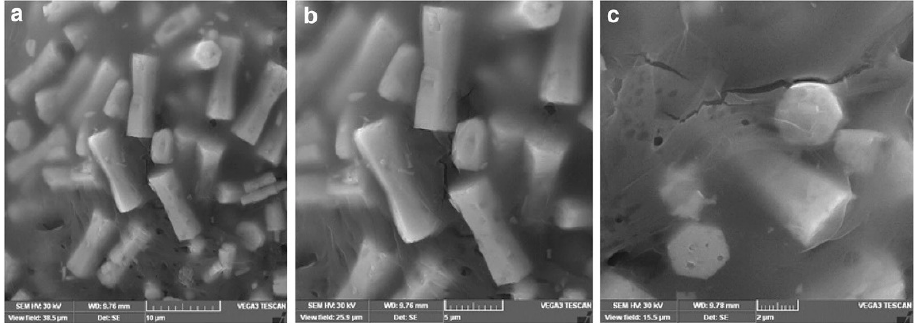
Figure 20. ( a – c ) Morphological property of micro-dumbbell-shaped rGO/ZnO composites using scanning electron microscopy. Reprinted by permission from Springer: Journal of Inorganic and Organometallic Polymers and Materials [117] Copyright, 2019.